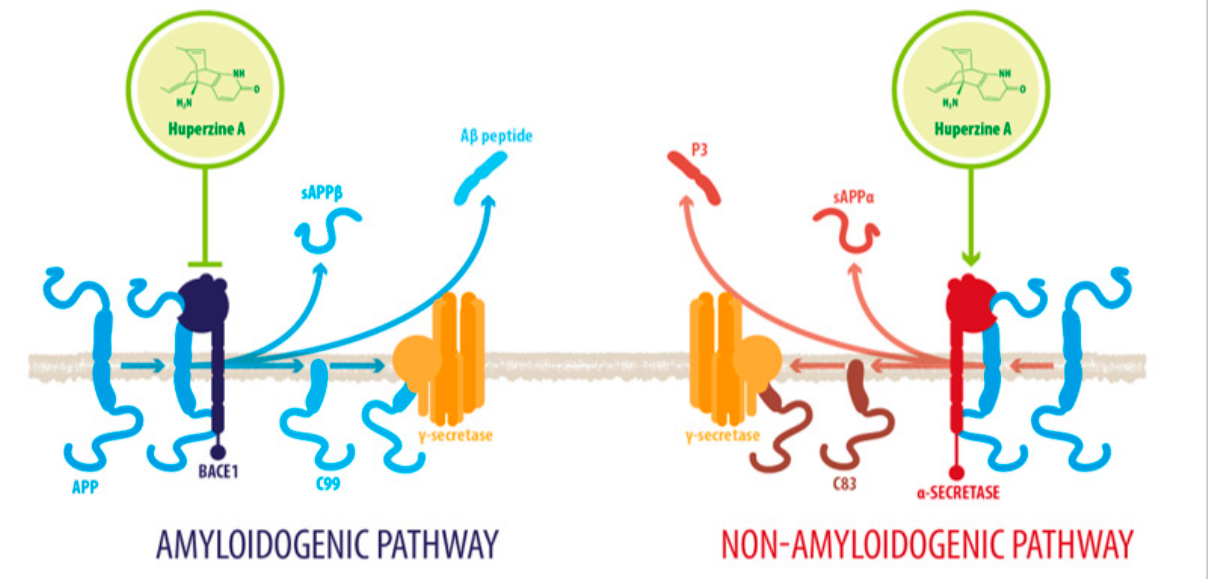
Figure 3. HupA regulates APP processing. HupA dose-dependently increases the activity of the nonamyloidogenic pathway through the cleavage of amyloid precursor protein (APP) by an α -secretase, producing soluble α -APP fragments, P3 peptide and a C83 fragment. These are both neurotrophic and neuroprotective and are upregulated after HupA treatment. HupA also reduces the levels of BACE1, a β / γ -secretase that produces soluble β -APP fragments in what is known as the amyloidogenic pathway, in addition to the C99 fragment that is cleaved to form the A β peptide. These products trigger apoptotic responses, such as neuronal membrane blebbing and cell shrinkage, leading to cell death (APP: amyloid precursor protein; BACE1: beta-site amyloid precursor protein cleaving enzyme 1; sAPP β : soluble amyloid precursor protein- β ; sAPP α : soluble amyloid precursor protein- α ).